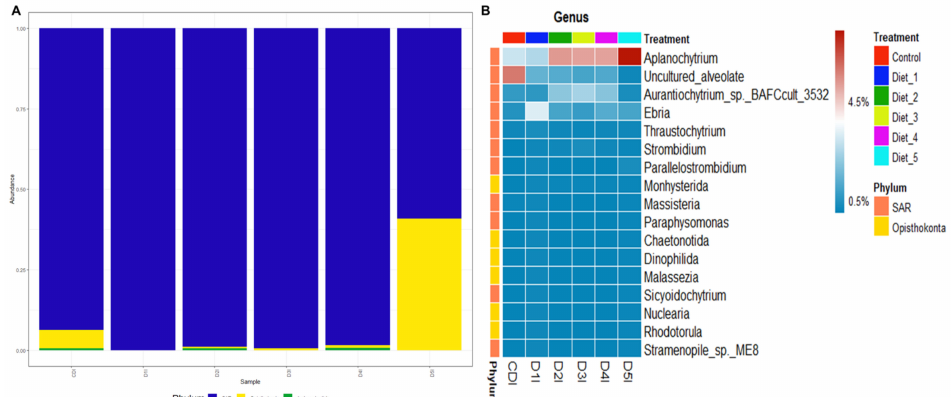
Figure 6. Eukaryotic microbiota of intestines from shrimp fed control diet and 50% fishmeal replace- ment diets. ( A ) Phyla abundance. ( B ) Heatmap analysis of genera abundance. Abbreviation: intestine (I). SAR (Stramenopiles, Alveolate y Rhizaria). CD (200 g/Kg FM), D1 (0.13% DL-MET), D2 (0.06% MET-MET), D3 (0.19% MET-MET), D4 (0.13% DL-MET plus 0.10% B. amyloliquefaciens CECT